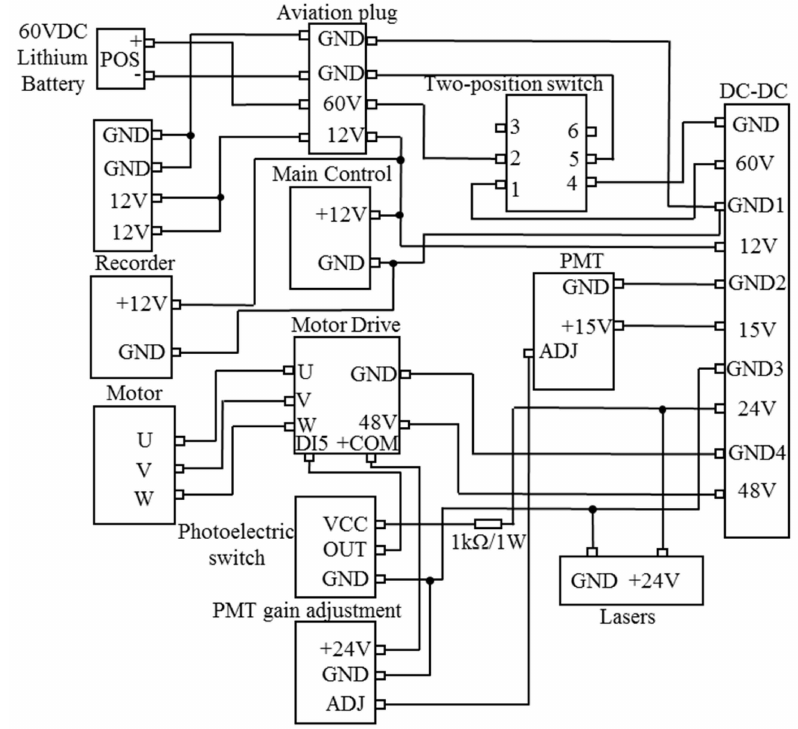
Figure 16. Wiring diagram of shipboard LiDAR system.